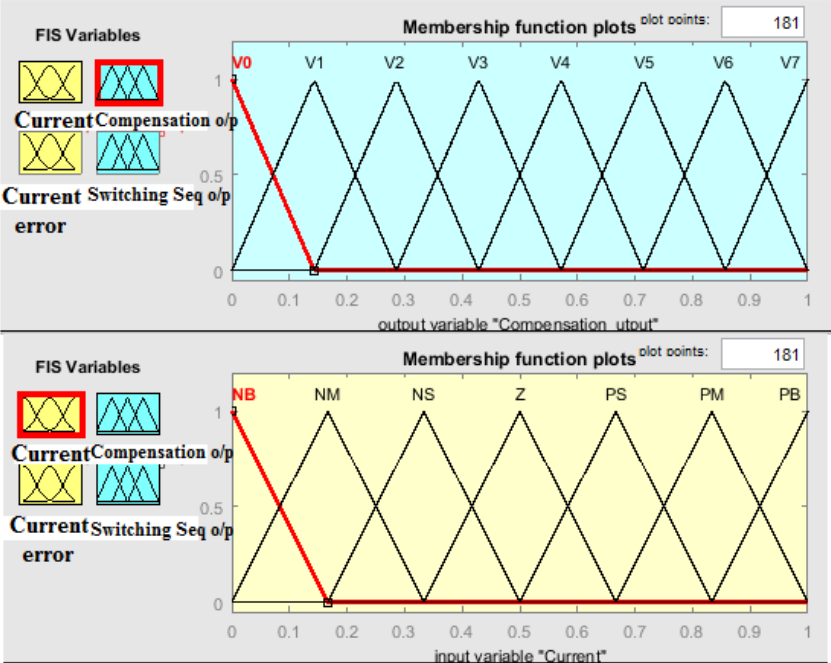
Figure 8. The membership function for output functions and the input current function.